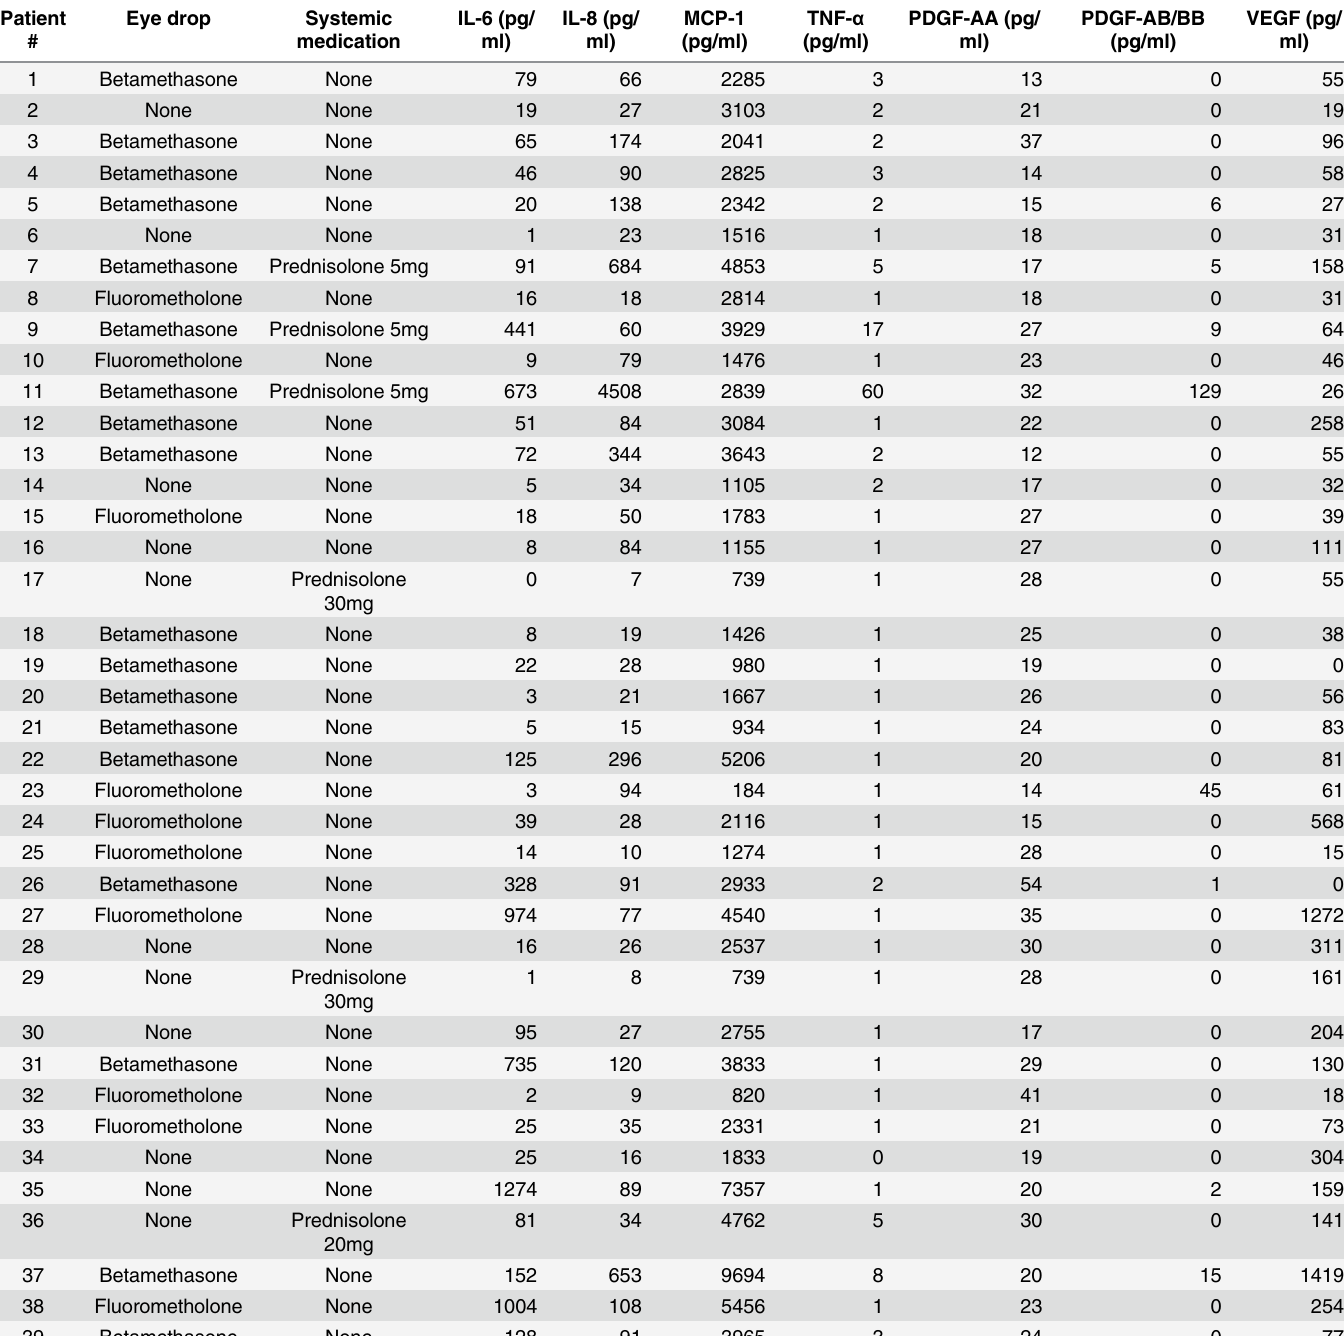
Table 2. Preoperative medications by corticosteroid and cytokine